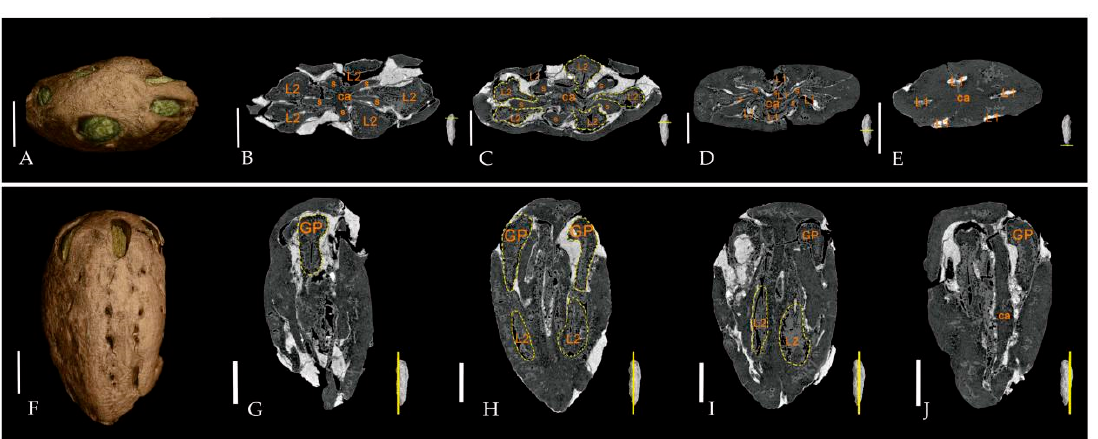
Figure 3. Characteristics of endocarps of Choerospondias tiantaiensis under a VHX-1000 super-depth- of-field microscope (( A – C ), JHU3-16-059; ( D – F ), JHU3-231). ( A , D ): Lateral view of endocarp showing the germination pores (yellow arrows). ( B , E ): Top view of endocarp showing the five germination pores (yellow arrows). ( C , F ): Base view of endocarp showing the five apertures in a whorl (yellow arrows). ( A , D ), scale bar = 2 mm. ( B , C , E , F ), scale bar = 1 mm.